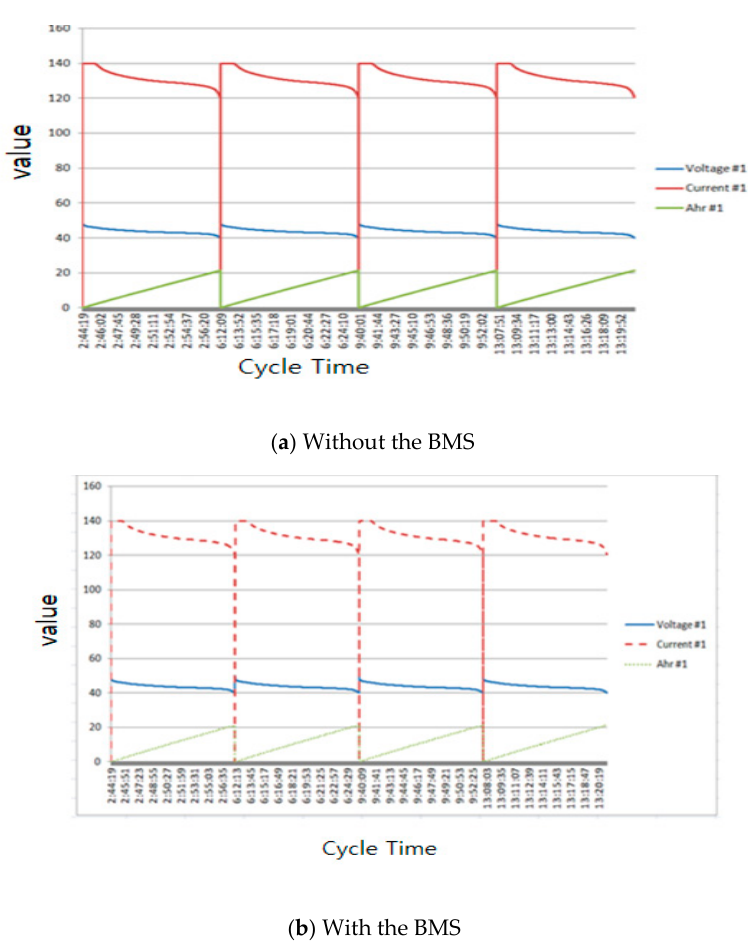
Figure 17. Comparison of the 0.2 C discharge outcomes: ( a ) Battery only, and ( b ) with the BMS.